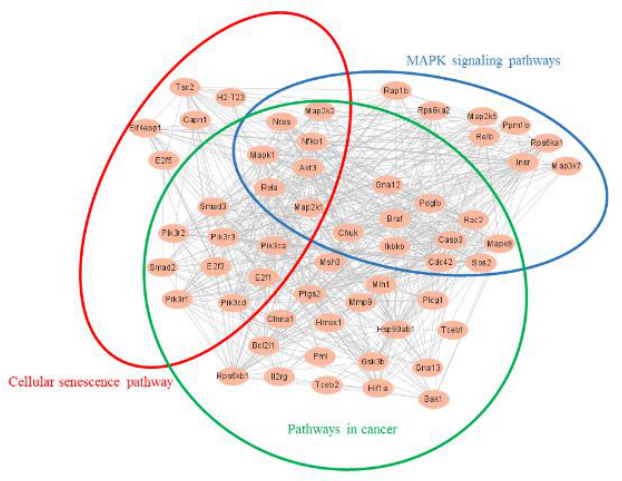
Figure 7. The protein-protein interaction subnetwork of all DEGs network in 320/LPS.